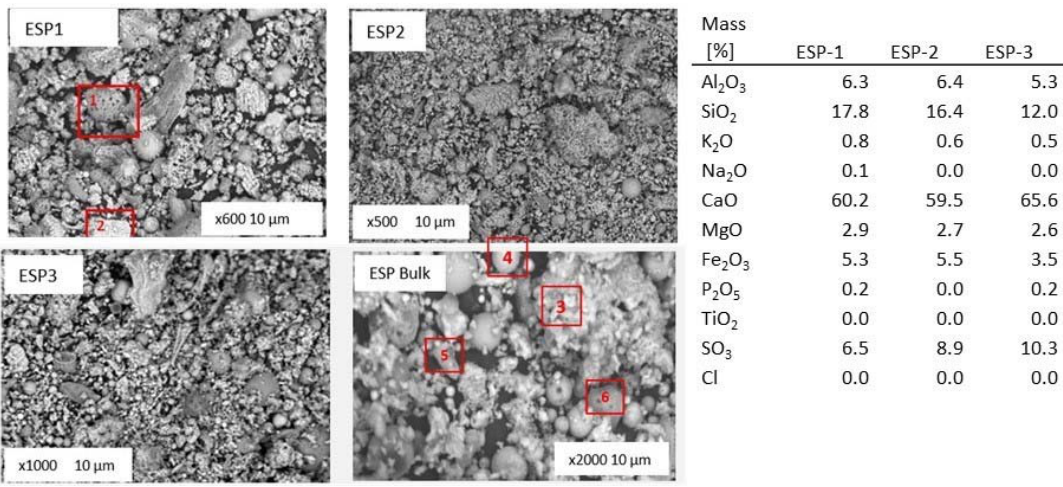
Figure 14. Backscattered electron images and energy dispersive X-ray (EDX) analyses of fly ash from pure lignite combustion.